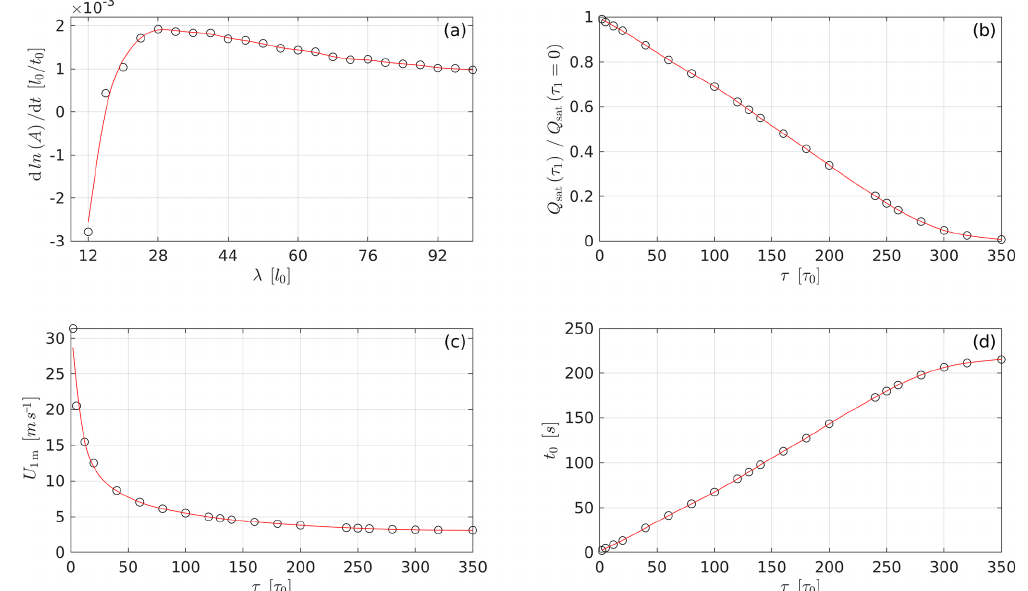
Figure 2. Establishing the length and timescales of the CA model. (a) Identifying the more unstable wavelength (see Eq. 4). λ max = 28 l 0 . (b) Variation in the Q ratio sat with τ 1 . (c) Variation in the velocity at 1m above the surface U 1m as a function of τ 1 . (d) Identifying the timescale t 0 of the model for different values of τ 1 Table 2. Details of the chosen wind scenarios for further analyses along with calculation of different quantities leading up to finding the relevant timescales for each wind speed. τ 1 Q ratio sat (model or real) a u b ∗ U